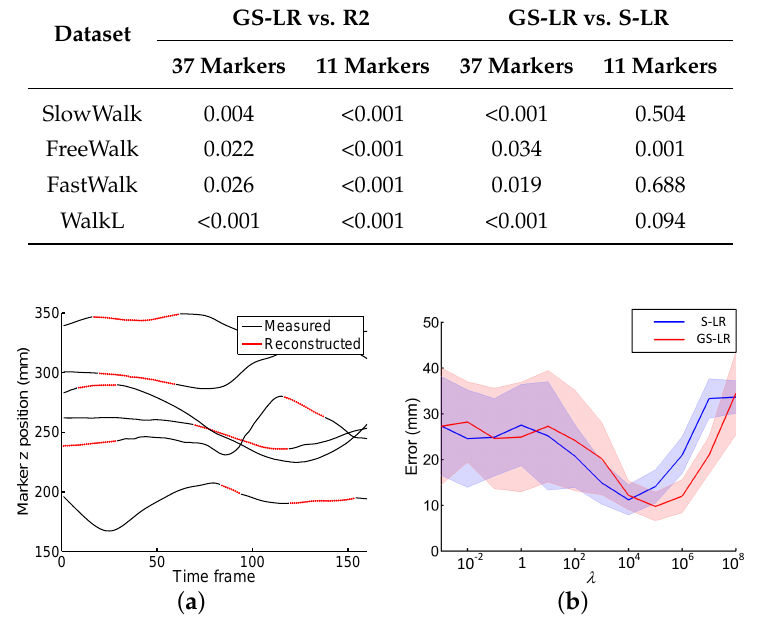
Figure 3. ( a ) A subset incomplete marker trajectories from the WalkL dataset, with recovered measurements shown in red. ( b ) Mean reconstruction error (mm) for different values of regularization parameter λ . Thick lines represent the intra-subject mean profiles and thin lines ± 1 standard-deviation margins.